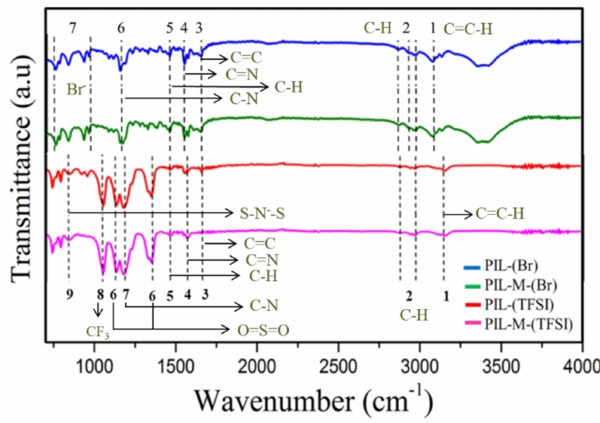
Figure 2. Fourier transform infrared spectroscopy (FTIR) spectra of PIL-(Br), PIL-M-(Br), PIL-(TFSI), and